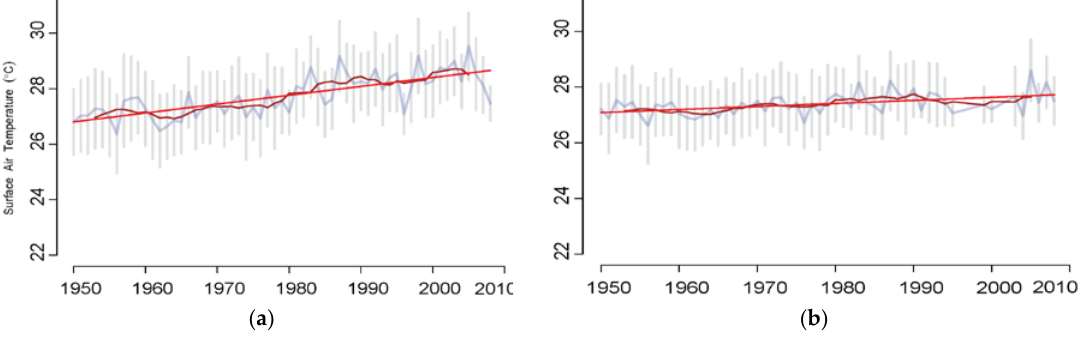
Figure 6. Observed trends (1950–2010) in observed annual maximum temperature at two climate stations within the Zambezi Basin: Mongu ( a ) and Mwinilunga ( b ). The y–axis is the temperature in degree Celsius (°C). The brown line represents the 5-year moving average while the red line is the simple linear trend line.